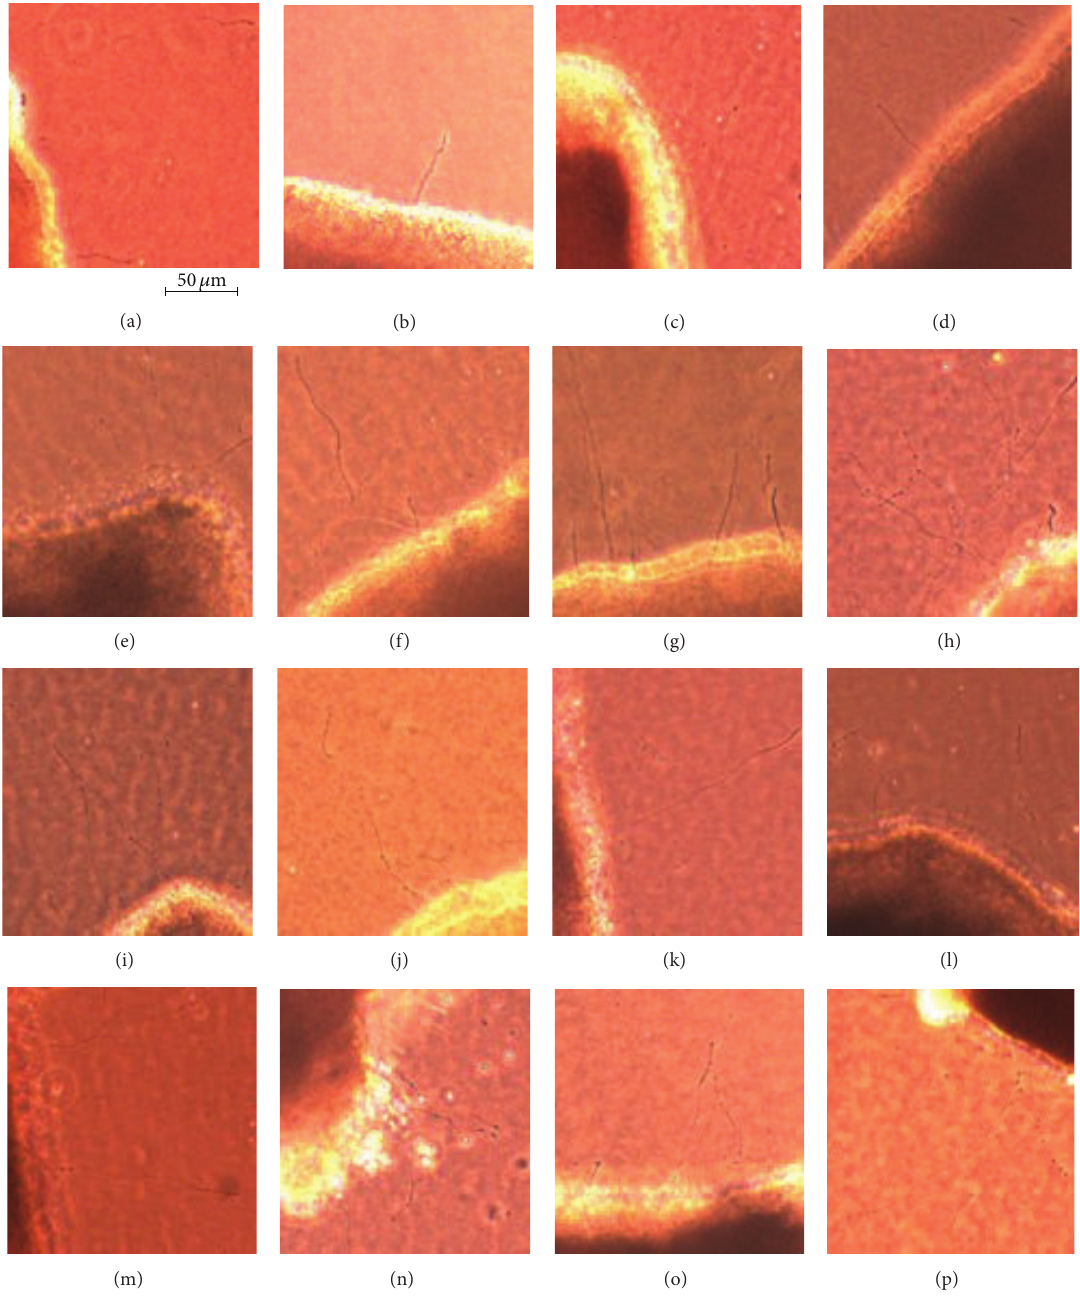
Figure 6: Representative photographs of regenerating neurites. Regenerating neurites are seen under phase-contrast microscopy. In the control serum-free media (a) neurites with normal length are present. In retinas cultured in glucose-AGE-BSA (b), glyceraldehyde-AGE- BSA (c), and glycolaldehyde-AGE-BSA (d), the neurites were shorter, and the numbers of neurites were fewer. In AGEs exposed retinas supplemented with NT-4 (glucose-AGE-BSA + NT-4 (e), glyceraldehyde-AGE-BSA + NT-4 (f), and glycolaldehyde-AGE-BSA + NT-4 (g)), the neurites are longer and thicker, and the number of neurites are higher even than in serum-free control media (a). In AGEs exposed retinas supplemented with HGF, GDNF, and TUDCA (glucose-AGE-BSA + HGF (h), glyceraldehyde-AGE-BSA + HGF (i), and glycolaldehyde- AGE-BSA + HGF (j)), (glucose-AGE-BSA + GDNF (k), glyceraldehyde-AGE-BSA + GDNF (l), and glycolaldehyde-AGE-BSA + GDNF (m)), (glucose-AGE-BSA + TUDCA (n), glyceraldehyde-AGE-BSA + TUDCA (o), and glycolaldehyde-AGE-BSA + TUDCA (p)), the neurites are longer and thicker than in AGEs exposed